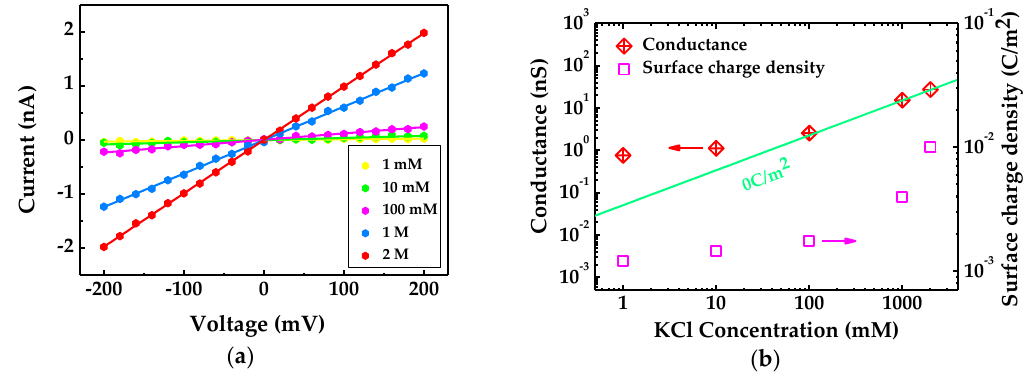
Figure 8. ( a ) I - V curve of a graphene nanopore with a diameter of 1.2 nm; and ( b ) the conductance and surface charge density against concentration of KCl. The green line shows the fitting without contribution of surface charge distribution.